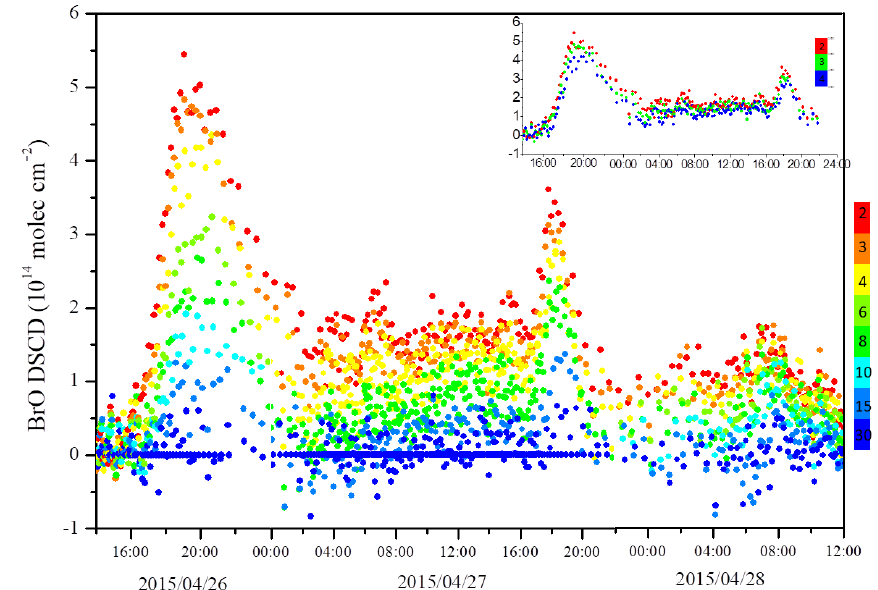
Figure 7. BrO DSCDs of different elevation angles during the enhancement period.